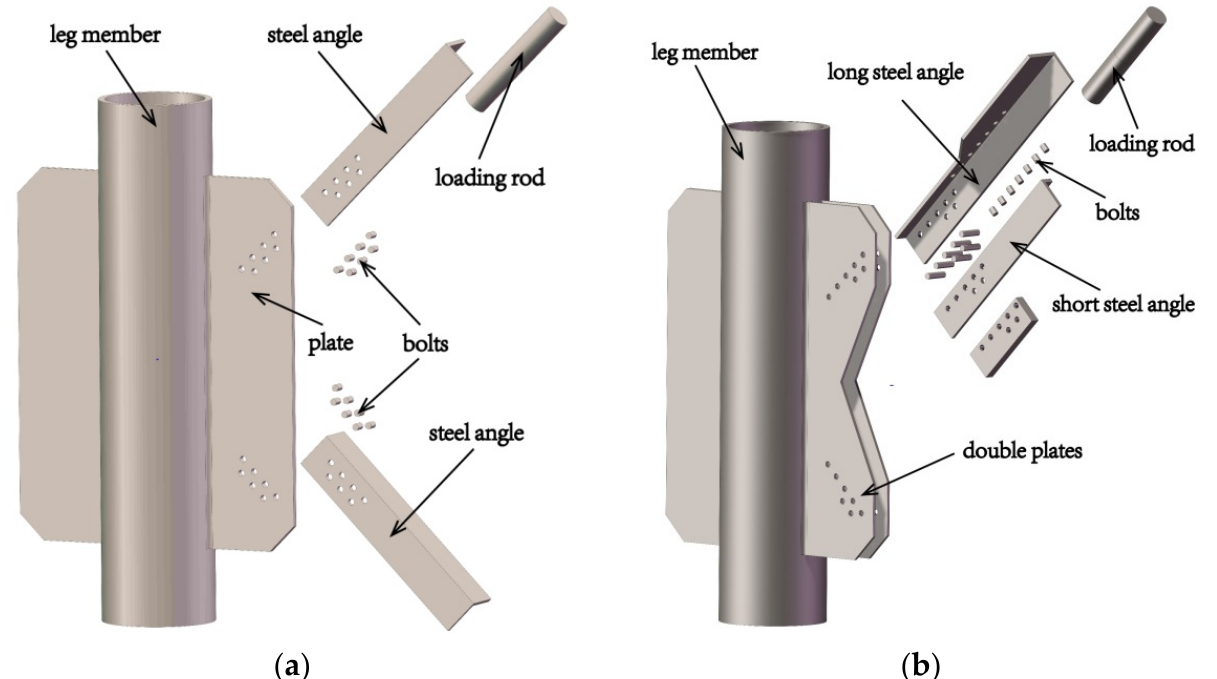
Figure 1. ( a ) Three-dimensional exploded view of single-limb single-plate gusset plate; ( b ) three dimensional exploded view of double-limb double-plate gusset plate.